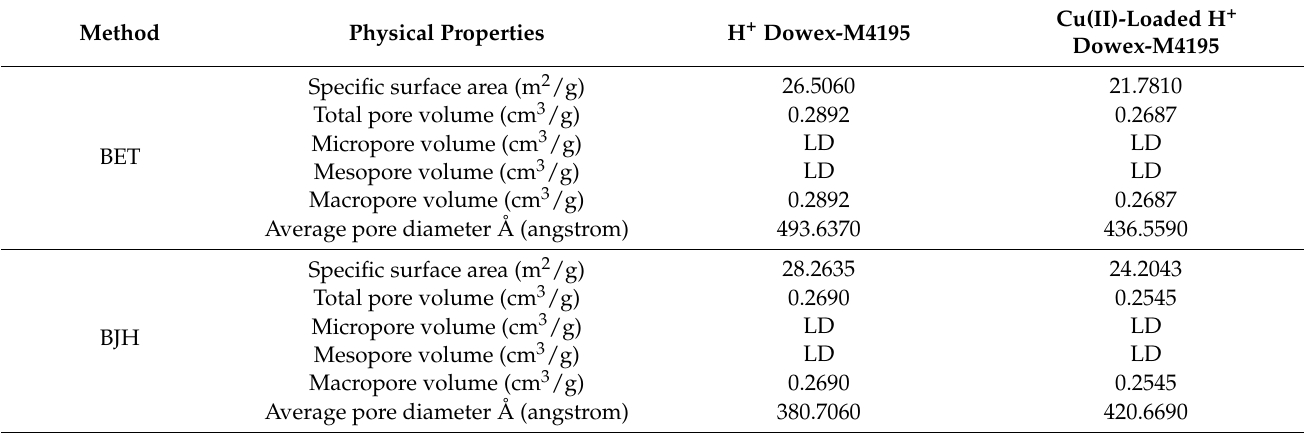
Table 2. Physical properties of H + Dowex-M4195 and Cu(II)-loaded H + Dowex-M4195 obtained from a different method.